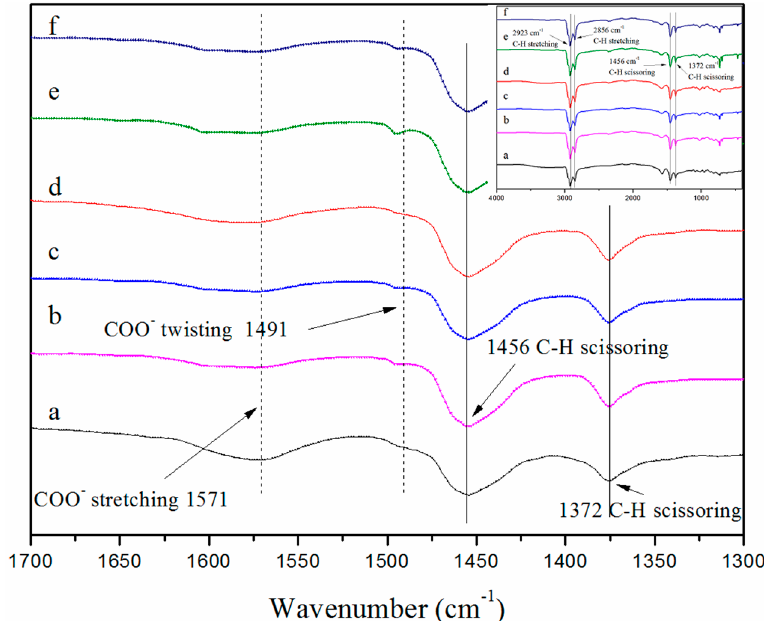
Figure 6. FT-IR spectra of: (a) asphalt from ChGly-assisted toluene extraction, (b) asphalt from ChHis-assisted toluene extraction, (c) asphalt from ChSer-assisted toluene extraction, (d) asphalt from ChPro-assisted toluene extraction, (e) asphalt from ChPhe-assisted toluene extraction, and (f) asphalt from pure toluene extraction. Table 5. Calculated solubility (x, mol/mol) of SARA fractions from asphalt and solvents in AAILs. Saturates Aromatics Resins Asphaltenes Toluene